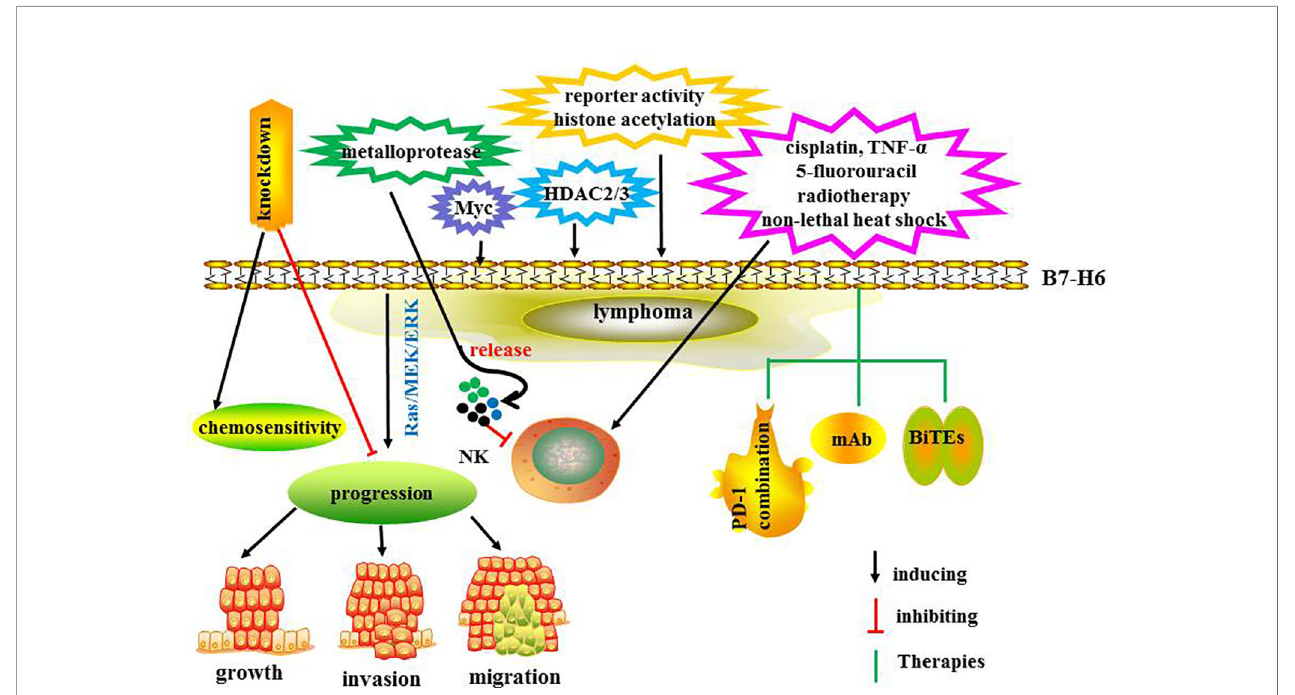
FIGURE 5 | The regulatory mechanisms and therapies targeting